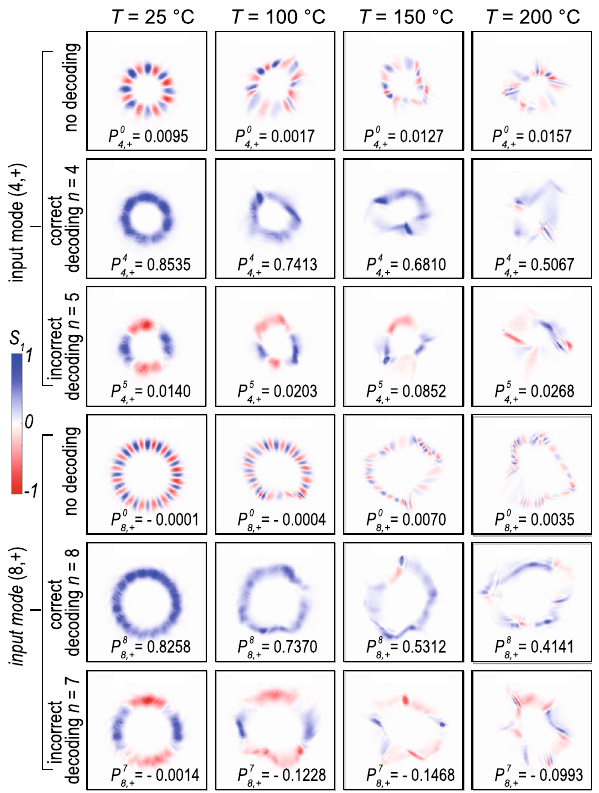
Fig. 6 Recorded polarization pro fi les through different decoding modules. The measured S 1 Stokes parameter pro fi le of input ( m = 4, + ) (upper) and ( m = 8, + ) (lower) vector vortex modes propagating through the free-space channel at various turbulence settings with no decoding, correct decoding, and incorrect decoding, respectively. The color indicates the value of the normalized S 1 parameter between − 1 and 1. More snapshots of the pro fi les can be found in Supplementary Movie 1 for input mode ( m = 4, + ) and Supplementary Movie 2 for input mode ( m = 8,